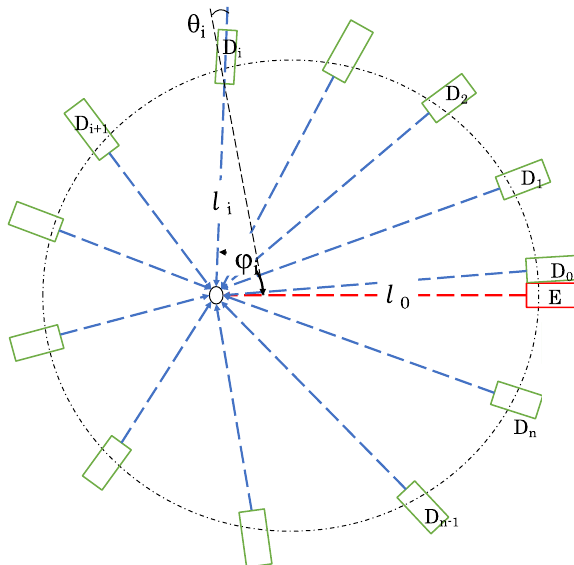
Figure 2. Schematic diagram of the proposed MIe Scattering Time–gated laSer LIDAR (MISTS–LIDAR) experimental set-up for obtaining the MIe scattering angular cross sections as a function of the wavelength of the incident laser light, complex refractive index of the scatterer, and size of the scatter. E (red rectangle) — laser source, D (green rectangles) — telescope detector, l i – distance between the scattering center and Di that is tilted at an angle θ i , l 0 —distance between the scattering center and the laser source.